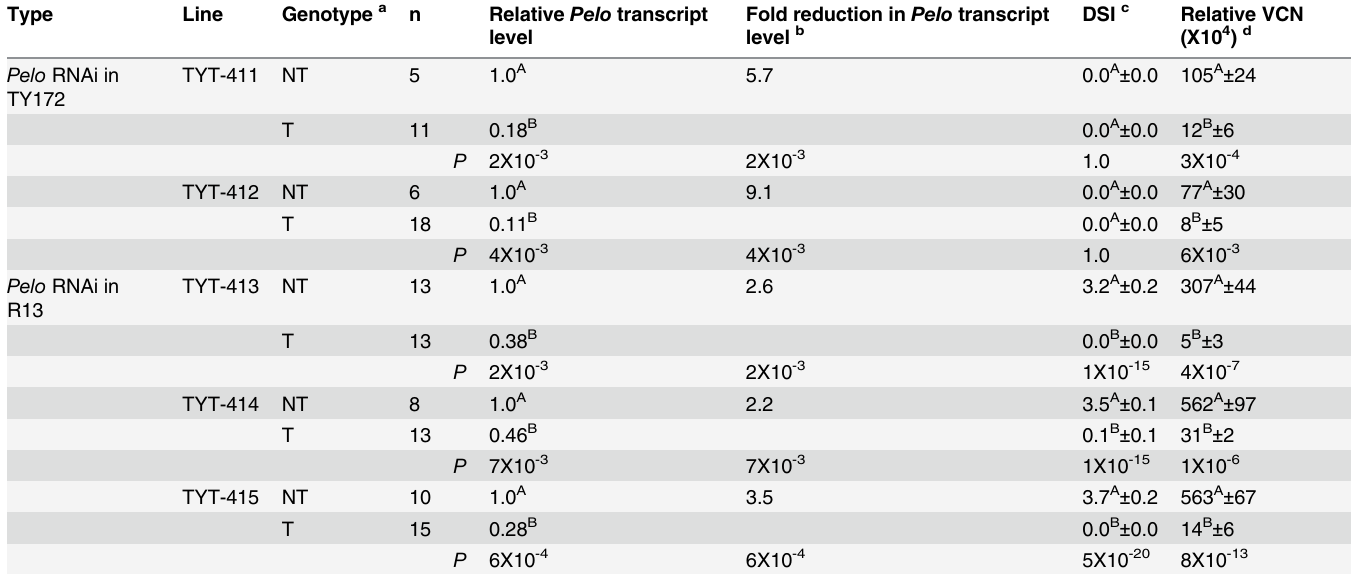
Table 4. Effect of Pelo silencing in transgenic susceptible (R13) and resistant (TY172) plants. Type